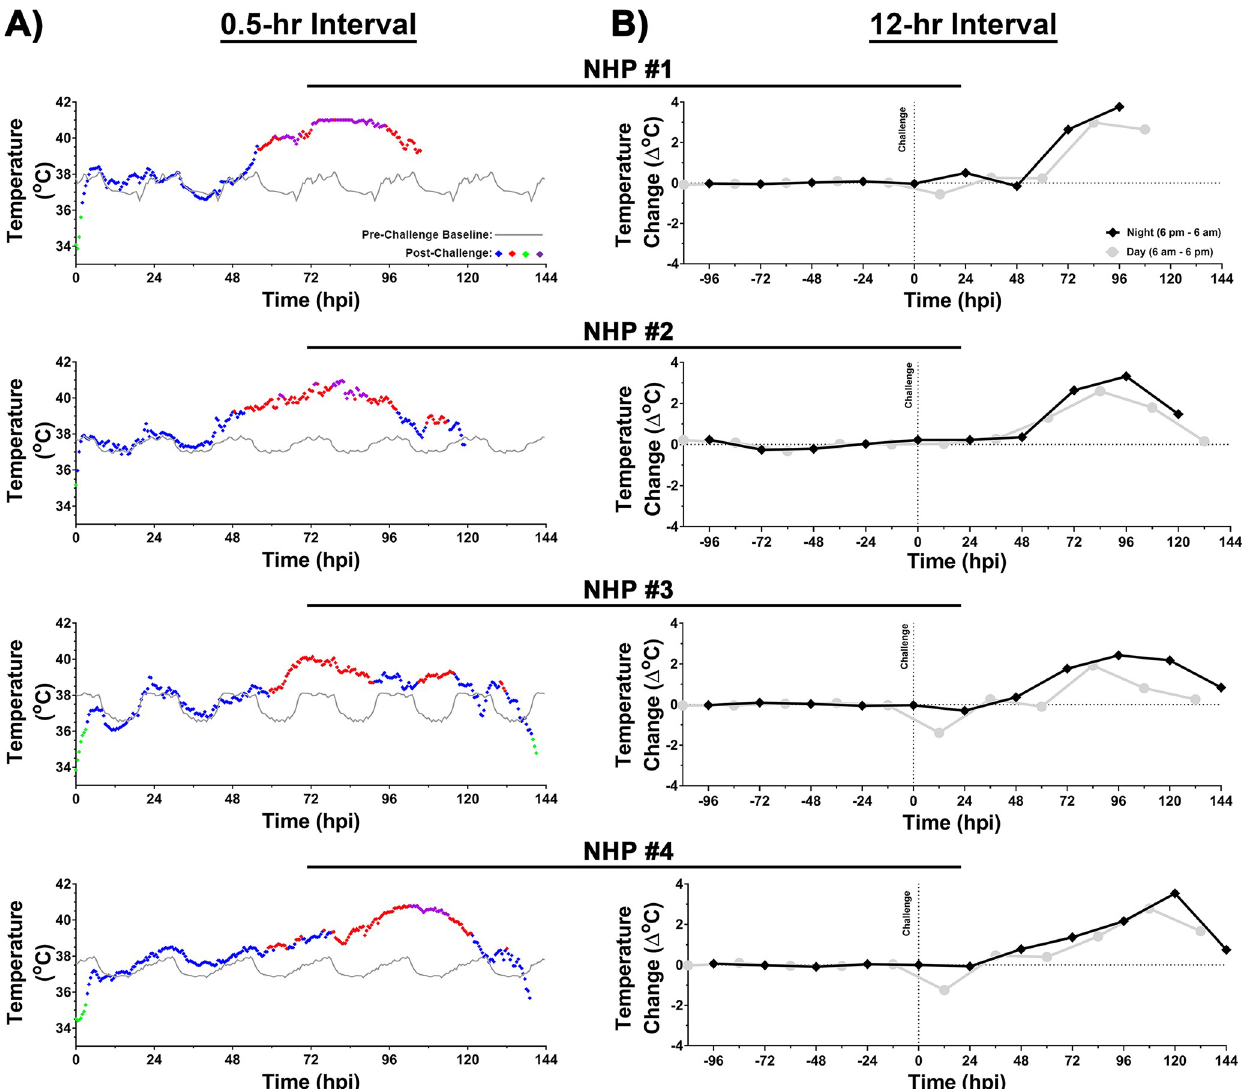
Fig 4. Body temperature of NHPs pre- and post-EEEV challenge. Data analysis is shown in 0.5- (A) and 12-hr (B) daytime/nighttime intervals. All NHPs were continuously monitored pre- and post-challenge. Pre-challenge baseline temperature was measured for five day/night cycles and a 0.5-hr interval baseline average was calculated by averaging raw data of five time-matched day or night time intervals. Forty-eight 0.5-hr interval averages were used to construct a baseline temperature for a day/night cycle and is shown as a grey line (A). Post-challenge values within � 3 standard deviations (SD) are indicated with ( ), > 3 SD above baseline are indicated with ( ), and > 3 SD below baseline are indicated with ( ). Hyperpyrexia is indicated by ( ) (A). Temperature change in a 12-hr interval is shown in grey (daytime) and in black (nighttime) (B). All raw data from either 12-hr daytime or nighttime intervals were averaged and normalized. The last data point for NHP #3 and #4 is an average of 8 hrs